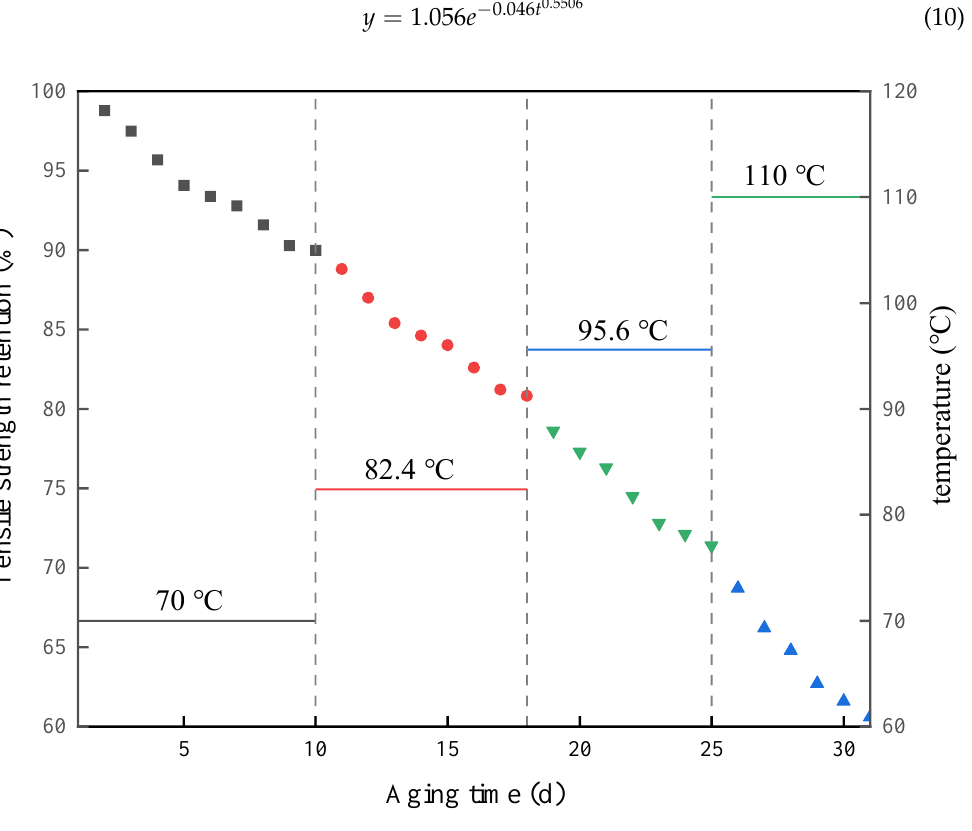
Figure 3. Changes in tensile strength retention with